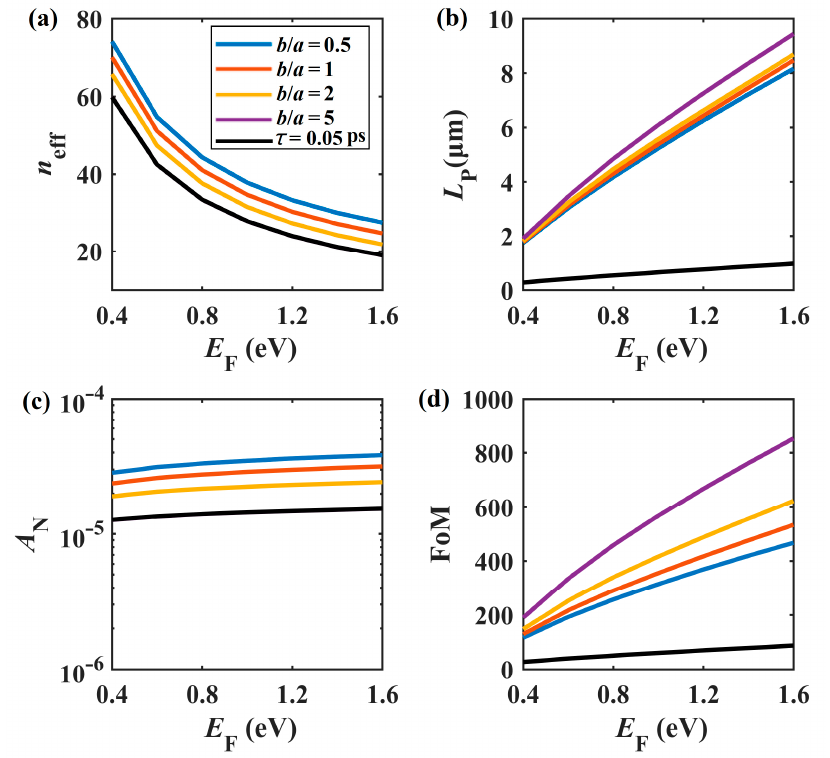
Figure 6. Modal properties of E F at different b / a values. ( a ) n eff , ( b ) L P , ( c ) A N , ( d ) FoM. Note that the black lines overlap the purple lines in ( a ) and ( c ).